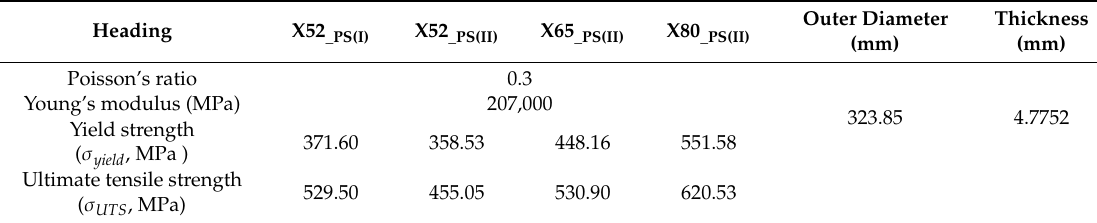
Table 1. Material properties and geometric information for finite element analysis (FEA) based parametric study (I) [12] and (II)